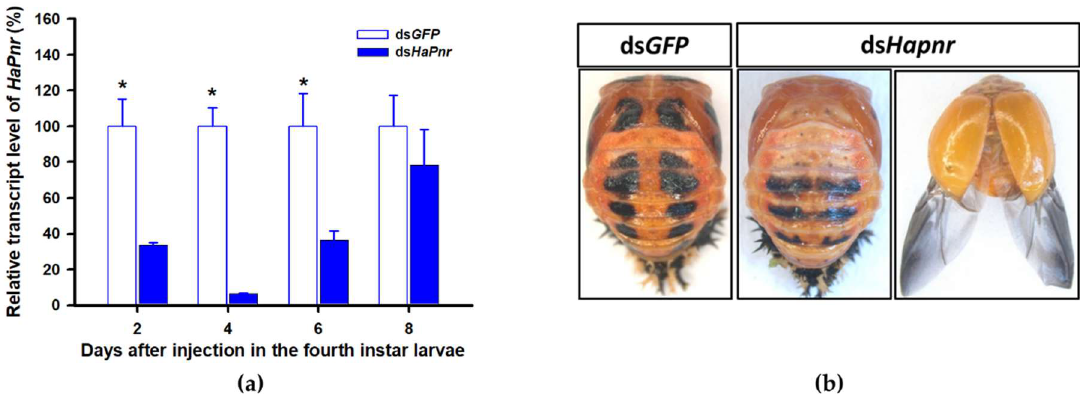
Figure 8. Time-dependent suppression of HaPnr transcript in the fourth instar larvae of H. axyridis injected with ds HaPnr at 300 ng / larva or ds GFP at 300 ng / larva as determined by RT-qPCR ( a ) and the phenotype of abnormal pupae and adult from fourth instar larvae injected with ds HaPnr ( b ). The relative transcription levels (%) are presented as the mean and SE of three replicates with three insects. Notability analysis was based on SPSS (v. 22, IBM Corp. Armonk, NY, USA) followed by One-Way ANOVA ( p < 0.05) within the same time point. ”*” indicates a significant di ff erence in relative transcript level of HaPnr between insect injected with ds HaPnr and ds GFP